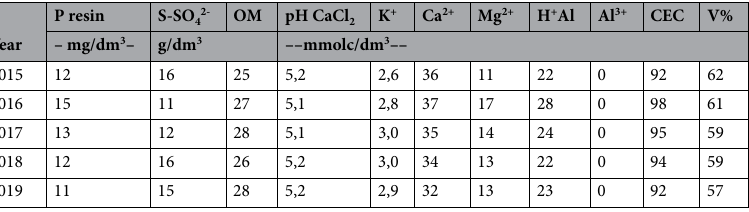
Table 3. Means soil chemical caracteristcs of the experimental area at the depth of 0 – 20 cm, Jaboticabal– SP. P = phospuros, S-SO 42- = sulfate, OM = organic matter, K = potassium, Ca = Calcium, Mg = magnesium, Al = alluminum, CEC = capacity os exchange cations and V% = bases